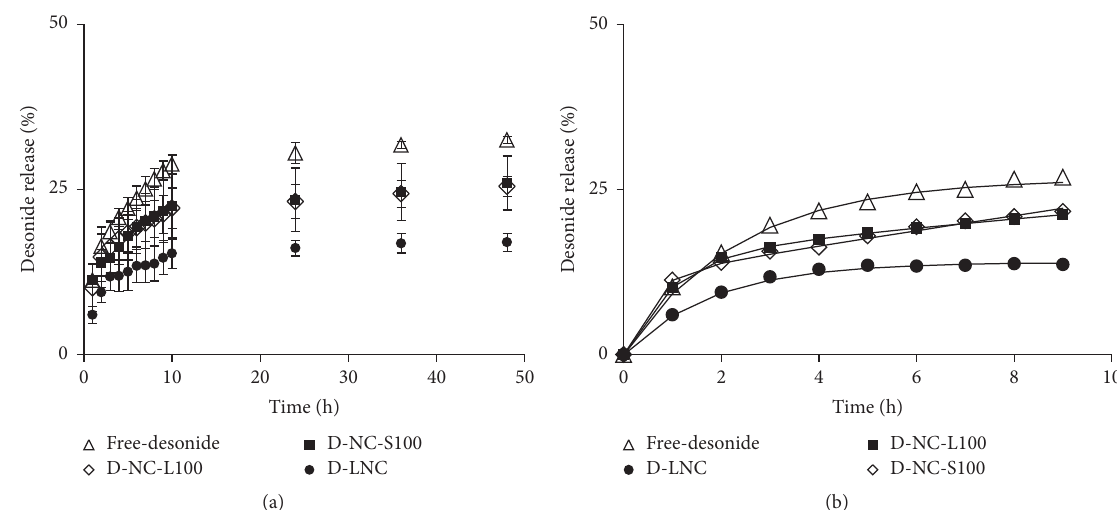
Figure 3: (a) Release profile of D-NC-S100, D-NC-L00, D-LNC, and free desonide using Franz diffusion cells. The scale of figures shown until 50%. Statistical significance among D-LNC and D-NC-S100; D-LNC and free desonide; D-NC-L100 and free desonide (Tukey, 𝑝 < 0.05 ). (b) The lines correspond to the fitting to the monoexponential equation for D-LNC and free desonide, biexponential equation for D-NC-L100 and D-NC-S100.